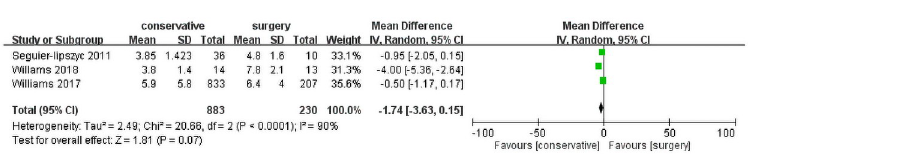
Fig 4. Length of hospital